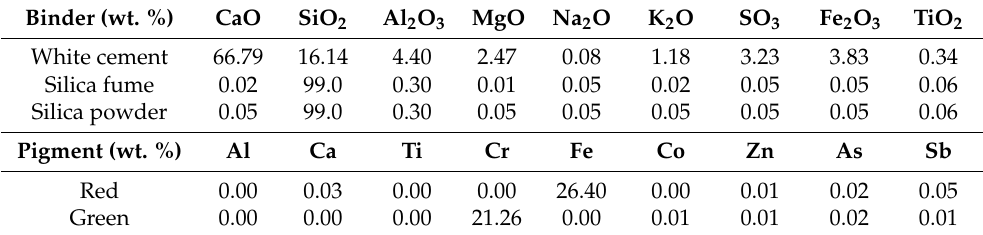
Table 1. Chemical compositions of binder and pigments. Binder (wt. %)